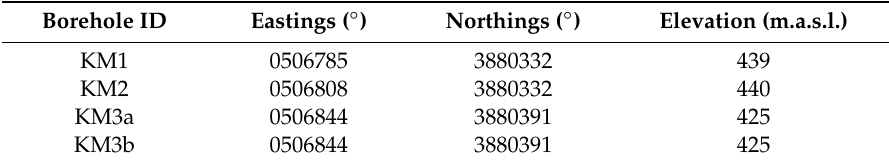
Table 1. Kato Moni borehole collar information (UTM/UPS WGS84 co-ordinate system).